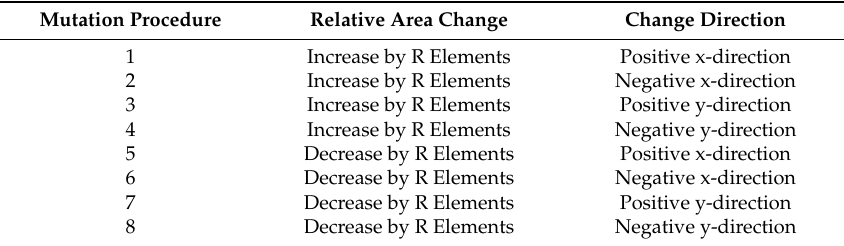
Table 5. Mutation procedures conducted in each optimisation